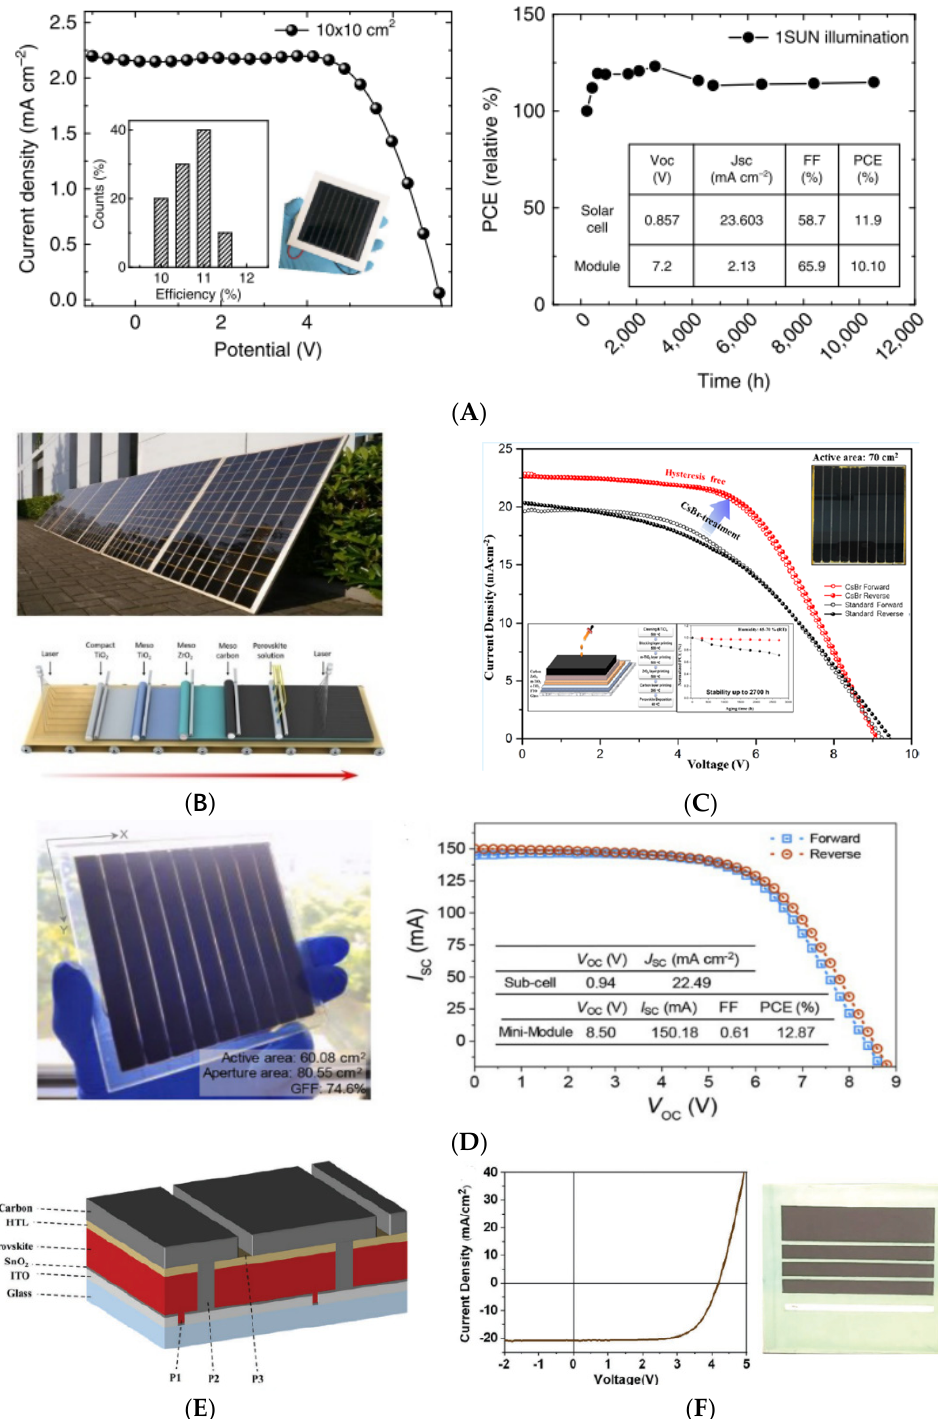
Figure 5. ( A ) JV curve of 2D/3D perovskite with 3% AVAI in 10 × 10 cm 2 module and module stability test under 1 sun; ( B ) 7 m 2 printable perovskite solar panels with HTCE and illustration of ideal product line; ( C ) JV curves with and without CsBr-modified TiO2 solar HTCE module and shelf life stability (inset); ( D ) Picture and JV curve of HTCE solar module with slot-die coating perovskite infiltration; ( E ) Module stack; ( F ) JV curve and picture of low-temperature carbon module on 25 cm 2 substrate using P3HT as HTM. Figure 5A,B is reproduced with the permission from references [63,108], respectively; Figure 5C,D is reproduced from references [110,111], respectively. Figure 5E,F is reproduced with permission from reference [83].